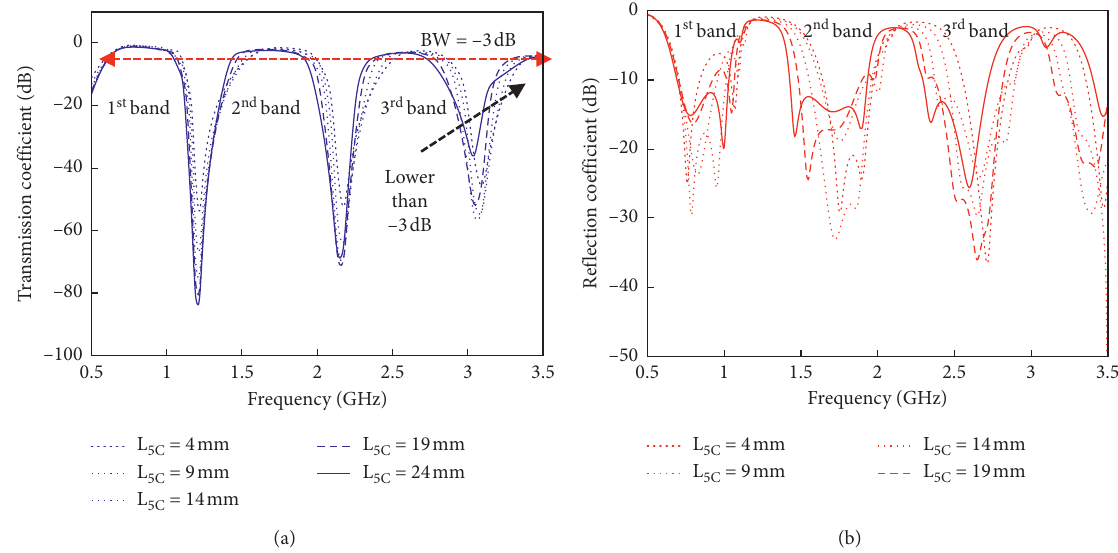
Figure 9: (a) Transmission coefficients ( S 21 ) of the proposed MW-BPF using a folded QC-SSIR with varied L 5 C values. (b) The reflection coefficients ( S 11 ) of the proposed MW-BPF using an FQC-SSIR with varied L 5 C